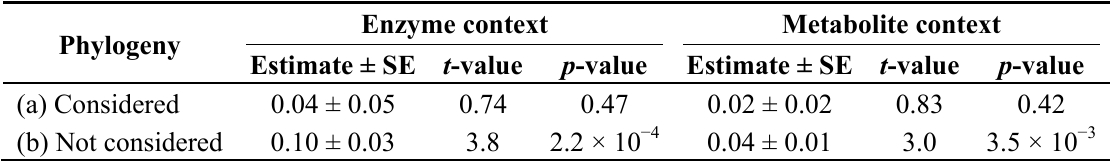
Table 1. Statistical tests for the impact of species oxygen requirements on the increase rate, calculated based on the number of enzymes and the number of metabolites, using linear models with (a) and without (b) consideration of a phylogenetic